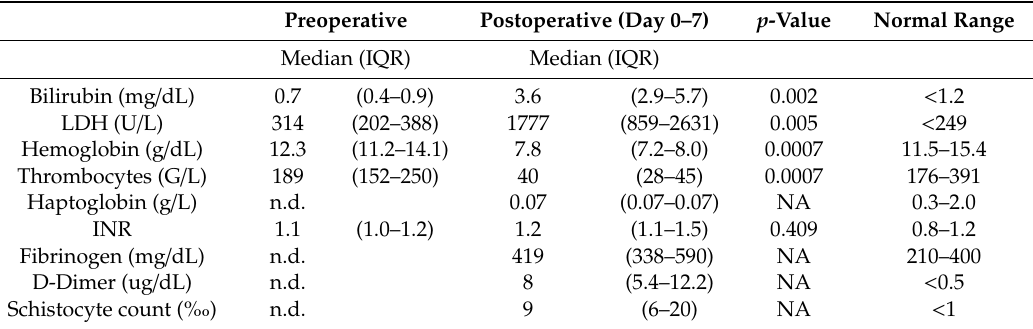
Table 4. Laboratory parameters of patients with TMA ( n =